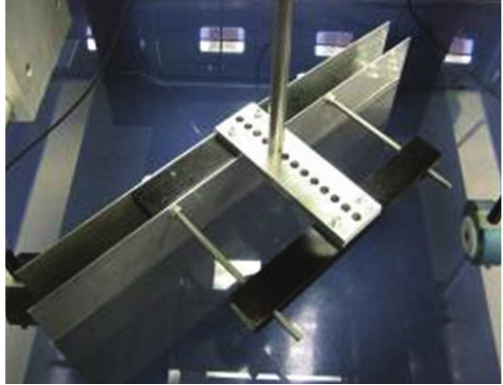
Figure 22: Inwater experimental mockup (300mm square